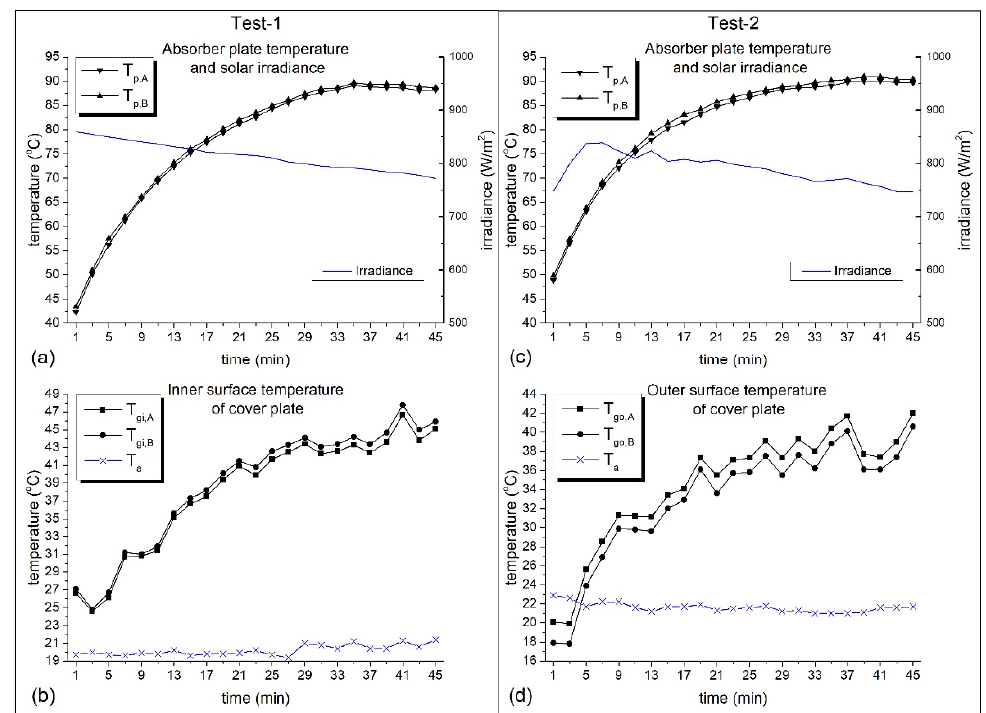
Figure 11. Temperatures in the two heat collecting processes: ( a ) the absorber plate temperature in Test-1; ( b ) the inner surface temperature of cover plate in Test-1; ( c ) the absorber plate temperature in Test-2; ( d ) the outer surface temperature of cover plate in Test-2.